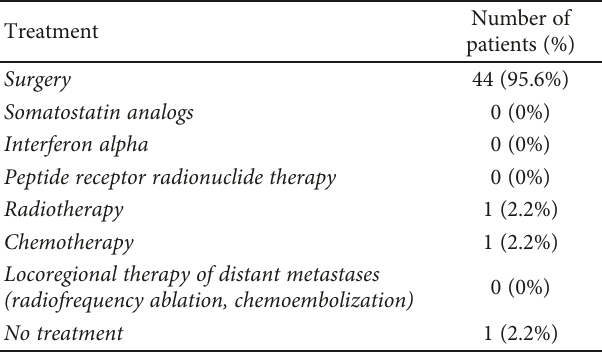
Table 3: Therapeutic management of bronchial NET patients diagnosed, treated, or followed-up at our institution from 1 st January 1995 to 31 st December 2015 ( n = 46 ). One patient underwent both radiotherapy and